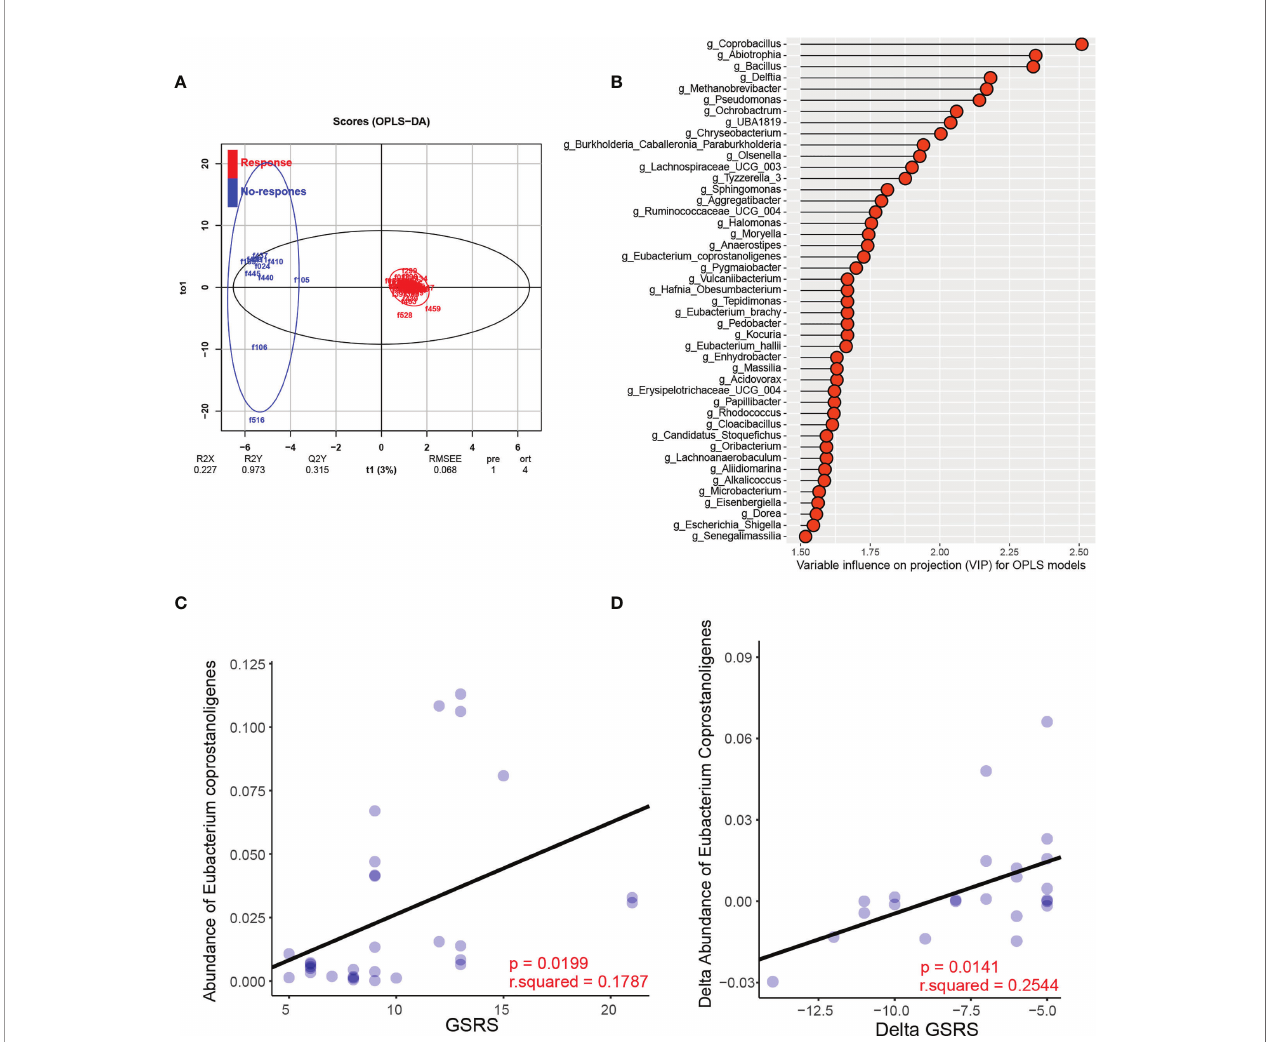
FIGURE 5 | Speci fi c microbial changes are associated with the response to FMT. (A) OPLS-DA analysis of the responder group and nonresponder group pre-FMT. (B) Variable in fl uence on projection (VIP) for OPLS models. (C) Correlation between the abundance of Eubacterium and GSRS scores post-FMT in the FMT recipients. (D) Correlation between the change in the relative abundance of Eubacterium after FMT and the change in GSRS scores after